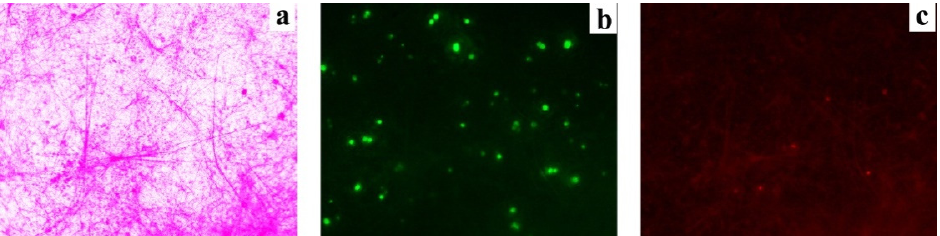
Time (min) Figure 11. Plot of viscosity against the temperature of C4-Azo-C5-HDA in water (2.0 wt%). The data were obtained at a constant frequency of 5 rad/s and a strain of 1.0%. 3.5. Live-Dead Assay of the Hydrogel Hydrogels formed by liquid crystals have received significant attention due to their high-tech applications, such as drug delivery, template materials, etc. [28–30]. In order to verify the biocompatibility of C4-Azo-C5-HDA hydrogels, live-dead assays were used to study the in vitro cell viability of human fibroblasts L929-supportive properties of C4- Azo-C5-HDA hydrogel. Figure 10 showed that the cells survived images under 5 wt% of the gelators after one day of culture. Figure 12b showed that the cells were perforated into the intermediate fibrous network, which caused the cells to show a different size and clar- ity under the fluorescence microscope. We concluded that, due to the existing release rate of small molecules from the hydrogel to the medium, the sol-gel has a dynamic equilib-